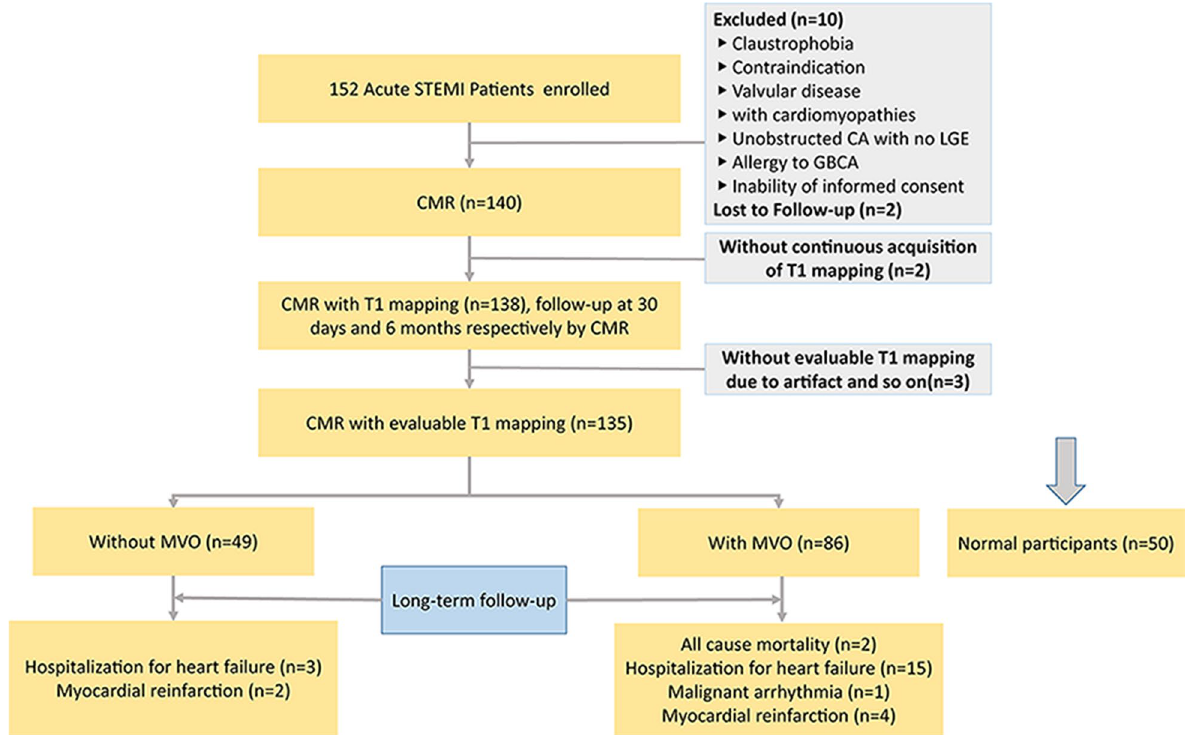
Fig. 1 Study flowchart. A total of 135 participants were available at the end of our present analysis. Fifty normal participants were recruited as the control